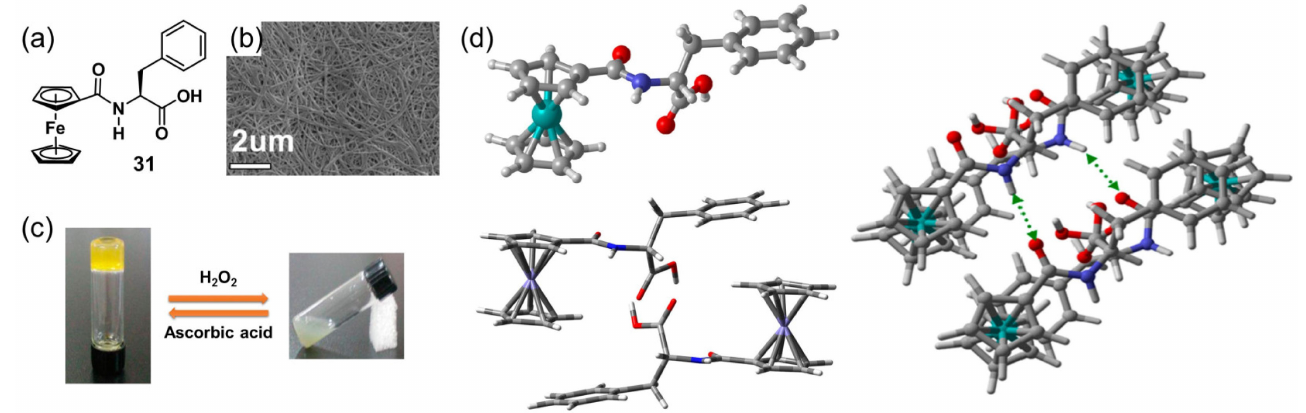
Figure 11. ( a ) Chemical structure of the gelator 31 . ( b ) SEM image of the cryo-dried hydrogel 31 . ( c ) Reversible gel − sol transitions of the supramolecular hydrogel triggered by chemical redox reaction. ( d ) Ab initio calculation of the self-assembly pathway of the Fc-F monomer. The red bar with a white end represents an − OH group, and the bar with a red end is the carbonyl group. Reprinted with permission from Ref. [61]. Copyright (2013), American Chemical